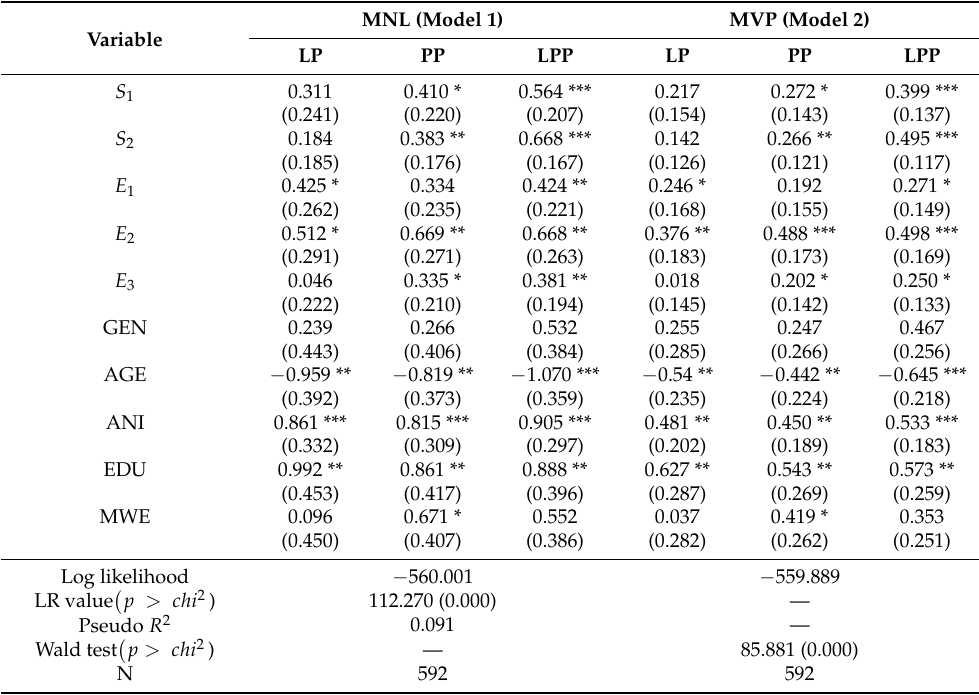
Table 3. Results of multinomial logit model for farmers’ preference for participating in rural solid waste